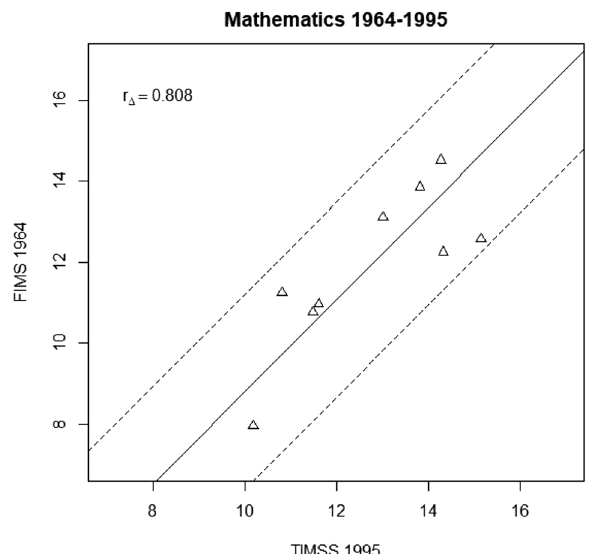
Fig. 6 Delta plot of the bridge between FIMS and TIMSS 1995